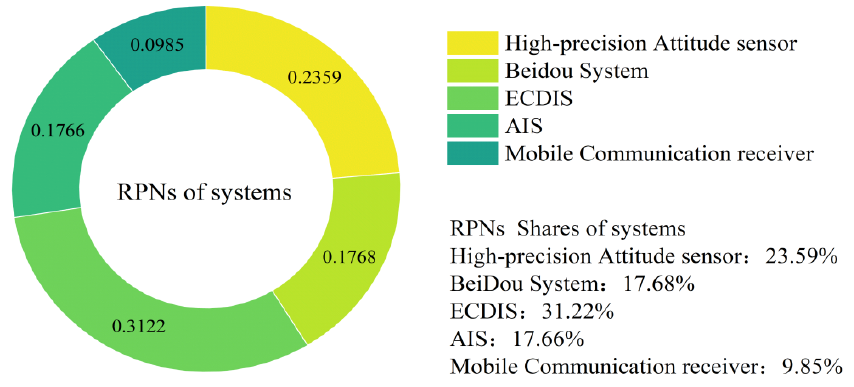
Figure 2. RPNs’ share of each subsystem of the positioning system.